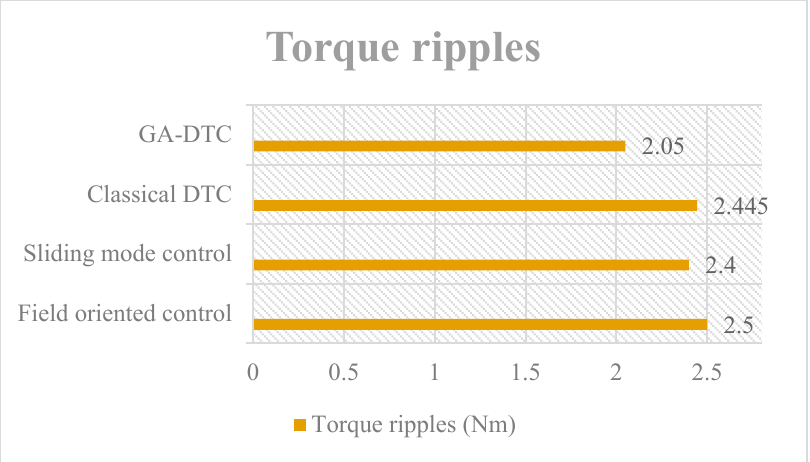
Figure 18. Histogram of various torque ripples of different strategies applied to the DFIM.